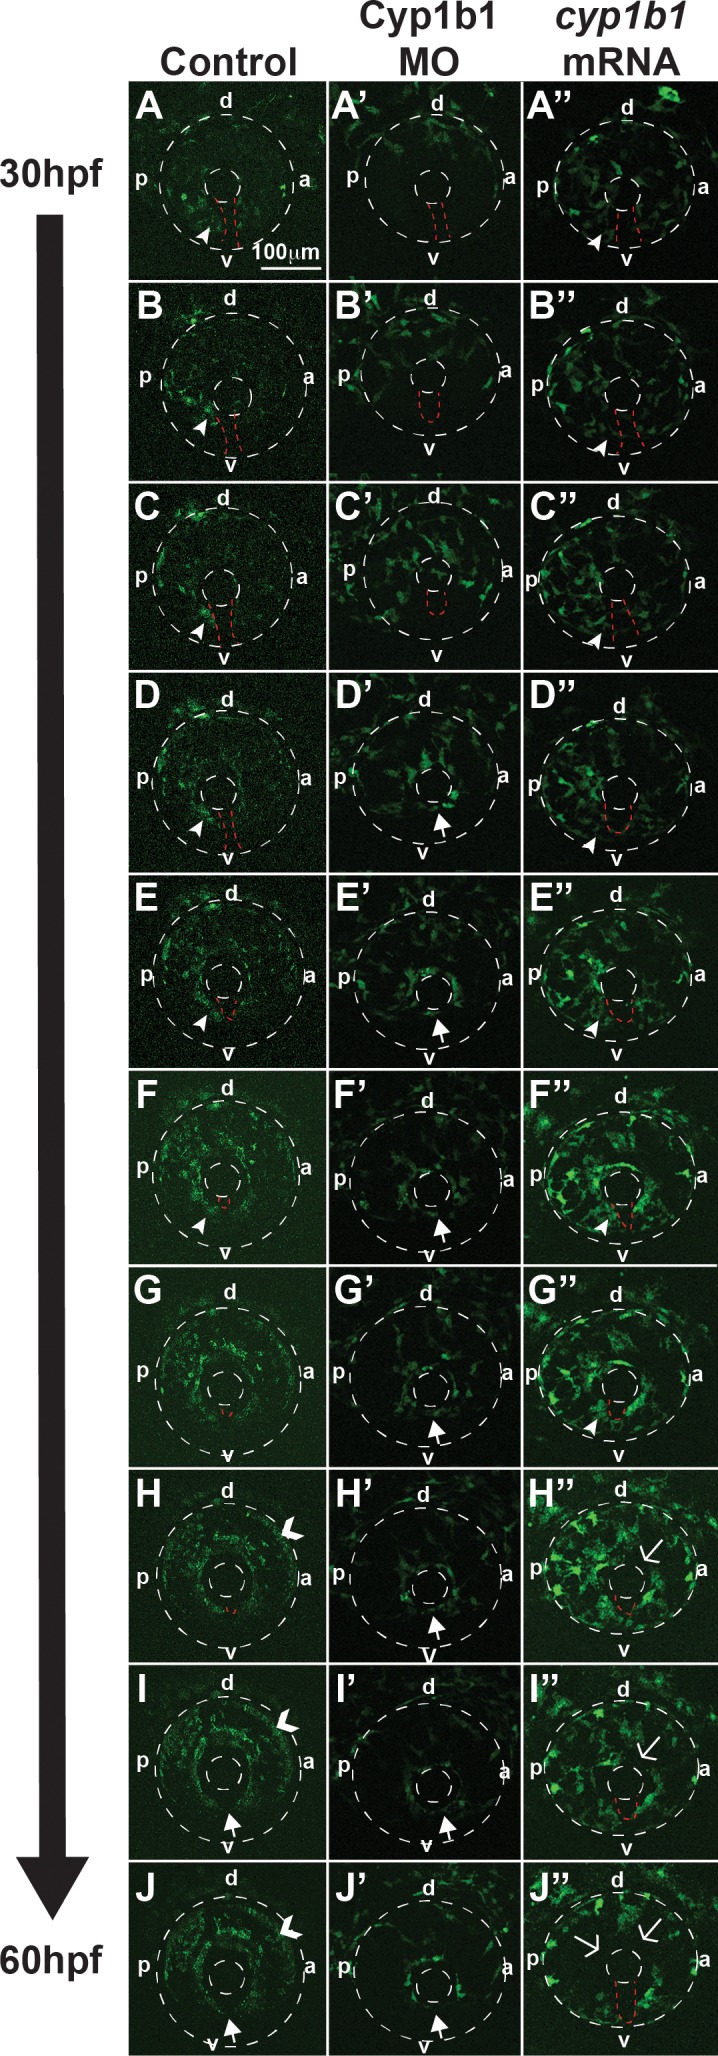
Cyp1b1 regulates ocular neural crest migration. Time-lapse imaging of Tg(foxd3:EGFP) control embryos from 30 to 60 hpf (A–J) showed that foxd3-positive cells entered into the anterior chamber between the surface ectoderm and optic cup, with more cells localized to the dorsal (d)–posterior (p) quadrant (E–H) compared with the anterior (a) and ventral (v) areas. In addition, foxd3-positive cells migrated adjacent to and through the ocular fissure (A–F, white arrowhead denotes migrating neural crest, red dashed line demarcates ocular fissure). At 60 hpf, foxd3-positive cells completely encircled the lens (I, J, closed arrows), indicating the closure of the fissure. In addition, at 60 hpf, foxd3 was also expressed in photoreceptors (H–J, open arrowhead). In Cyp1b1 MO knockdown embryos, Foxd3-positive cells travelled between the surface ectoderm and optic cup in the dorsal quadrants (A'–E'), but there were few cells adjacent to and in the ocular fissure. Foxd3-positive cells encircled the lens prior to controls (D'–H' versus D–H), indicating the premature closure of the fissure. At 60 hpf, there were fewer foxd3-positive cells in the eye (J'). In embryos overexpressing cyp1b1, ocular neural crest migration was less organized, as foxd3-positive cells were located throughout the posterior half of the eye (A''–G''). Further, the ocular fissure remained open and prevented the continuous coalescence of neural crest cells around the lens (H''–J'', open arrows), resulting in fewer neural crest cells at 60 hpf (J'').